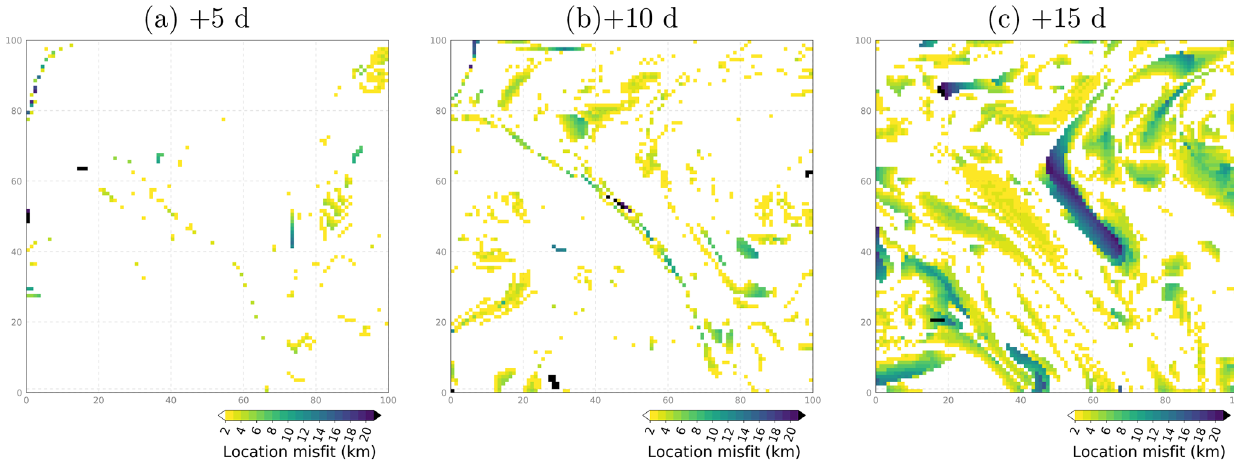
Figure 13. Location misfit (in km) between the surface salinity fields of two example members in the ensemble experiment ENS-CI after 5, 10 and 15d (from left to right), focusing on a subregion southeast of the Balearic Islands: box (c) in Fig. 1.